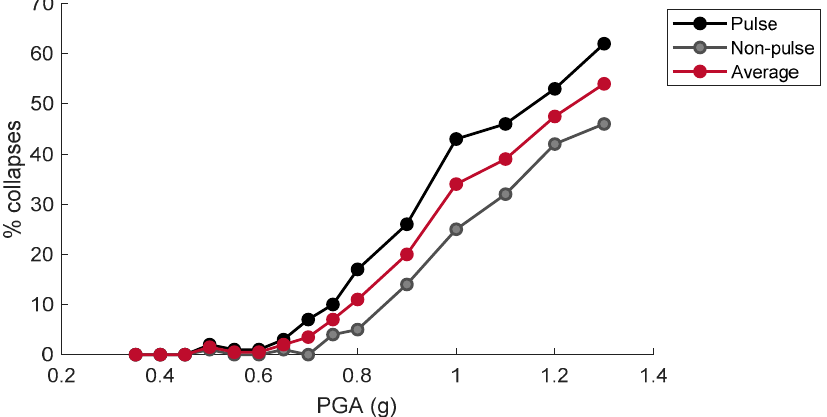
Figure 17. Masonry wall with openings. Variation of number of collapses predicted using rocking dynamics with PGA, for both pulse and non-pulse type recorded ground motions.